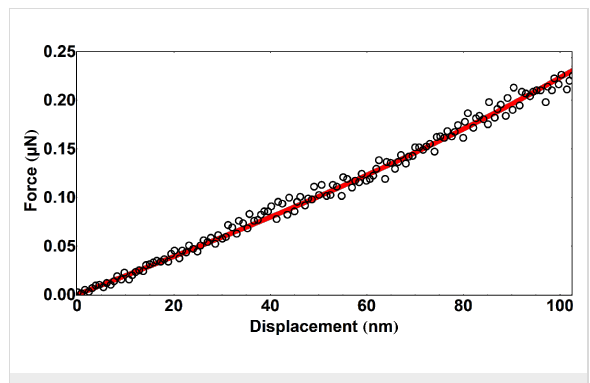
Figure 4: Fitting of three-point bending test of silica NT in AFM.